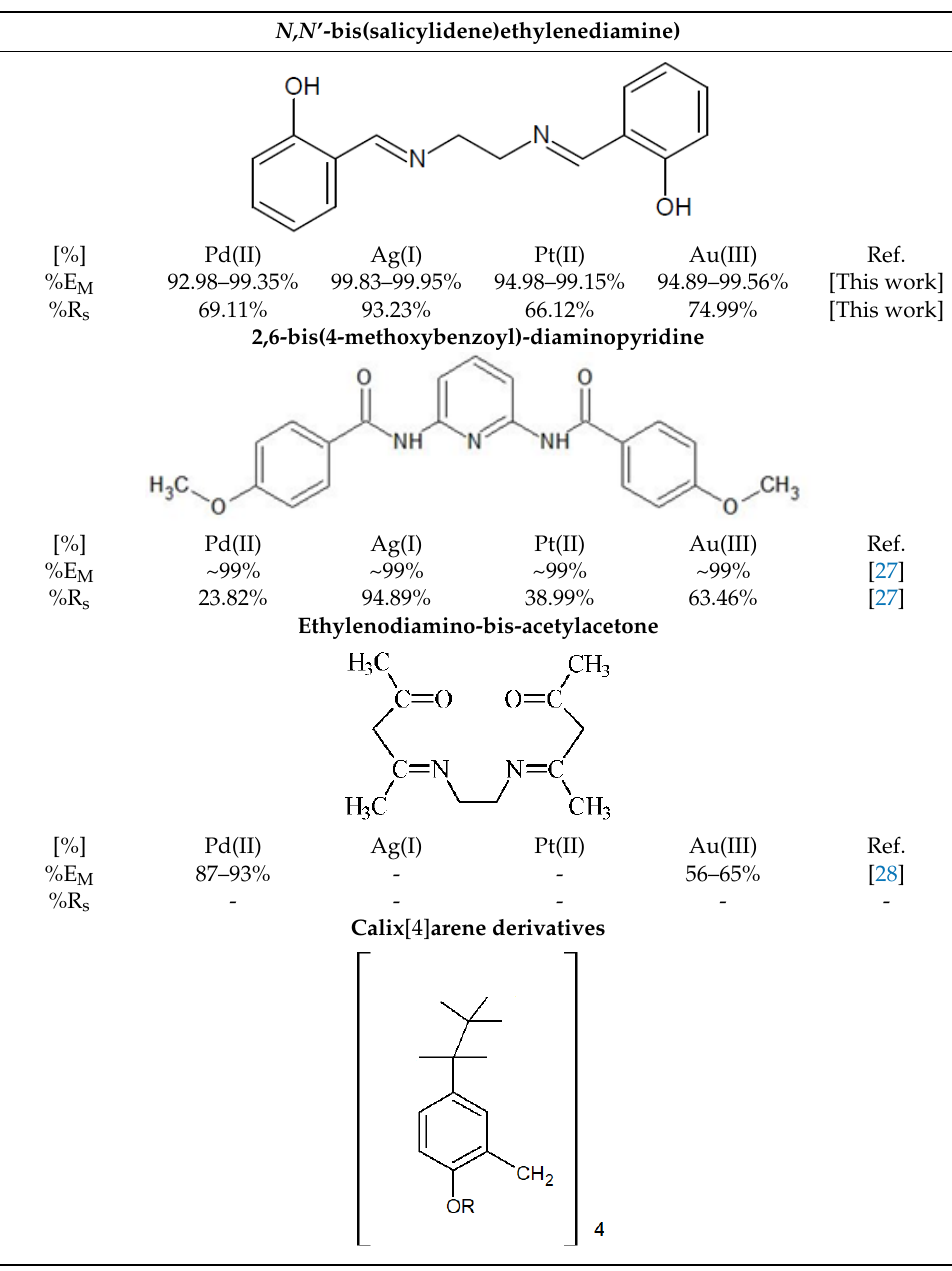
Figure 12. ESI-HRMS spectra recorded for the samples of the separated organic phases after liquid– liquid extraction containing N,N’ -bis(salicylidene)ethylenediamine (L) and Pd 2+ ( left ) or Pt 2+ ( right ) ions, respectively. Unassigned minor signals correspond to ions not relevant to this study (e.g., formed by solvent molecules).